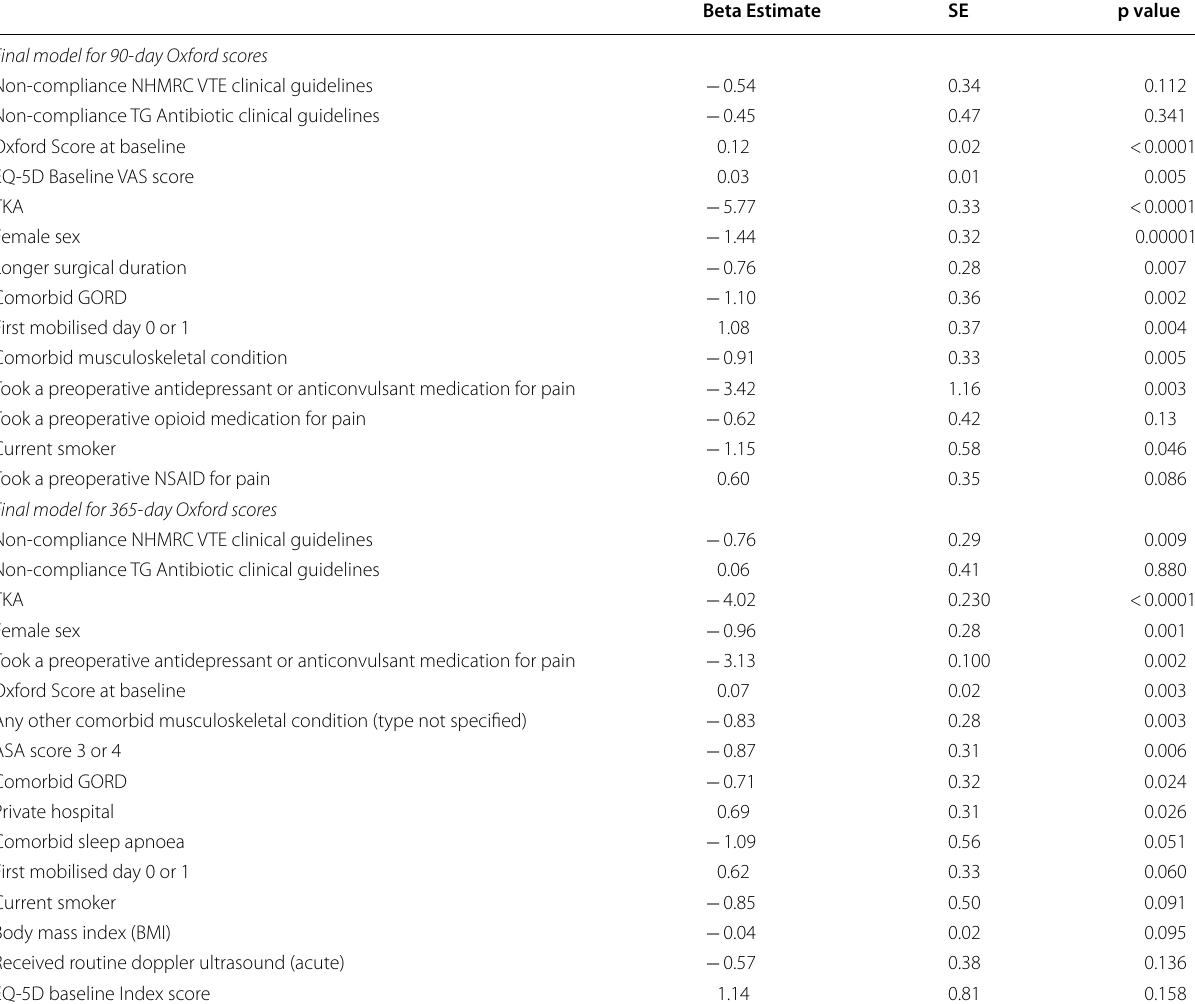
Table 6 Association between antibiotic and VTE non‑compliance and 90‑day Oxford scores